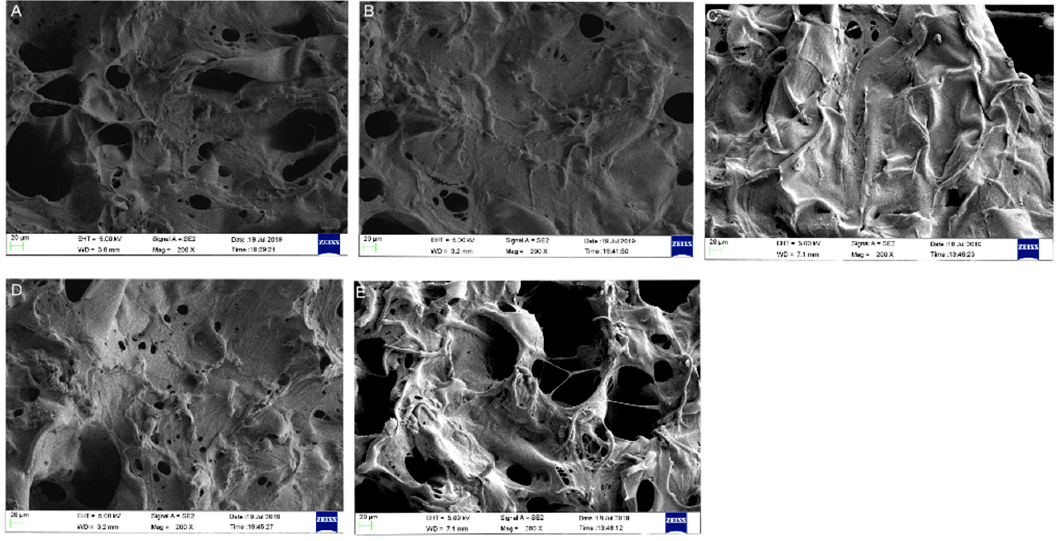
Figure 9. Scanning electron microscope (SEM) photographs of bone marrow mesenchymal stem cells cells (BMSCs) seeding on the SF / SPI-based composite sca ff olds (( A ): SF; ( B ): SF / SPI; ( C ): SF / SPI / GO; (BMSCs) seeding on the SF/SPI-based composite scaffolds (( A ): SF; ( B ): SF/SPI; ( C ): SF/SPI/GO; ( D ): ( D ): SF / SPI / β -TCP; ( E ): SF / SPI / GO / β SF/SPI/ β -TCP; ( E ): SF/SPI/GO/ β -TCP).